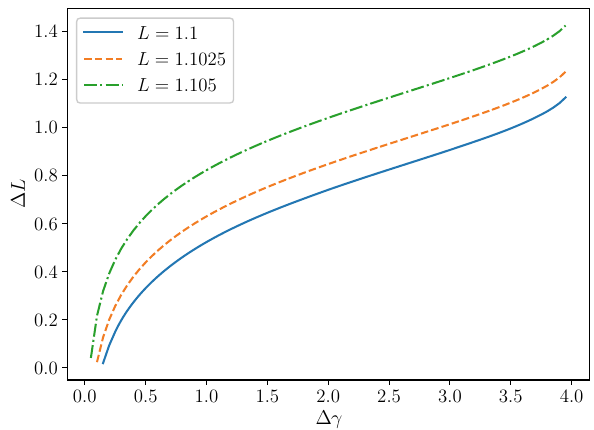
Fig. 3 Relationship between parameters of the linearized potential, (cid:8)γ versus (cid:8) L , for different values of L considering γ = 4 . 0